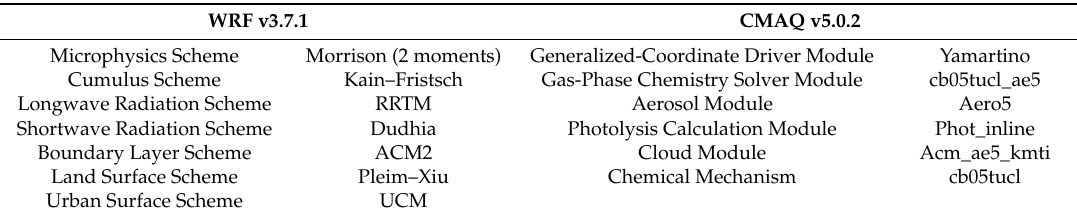
Table 1. The configuration of physical parameterization for WRF model.